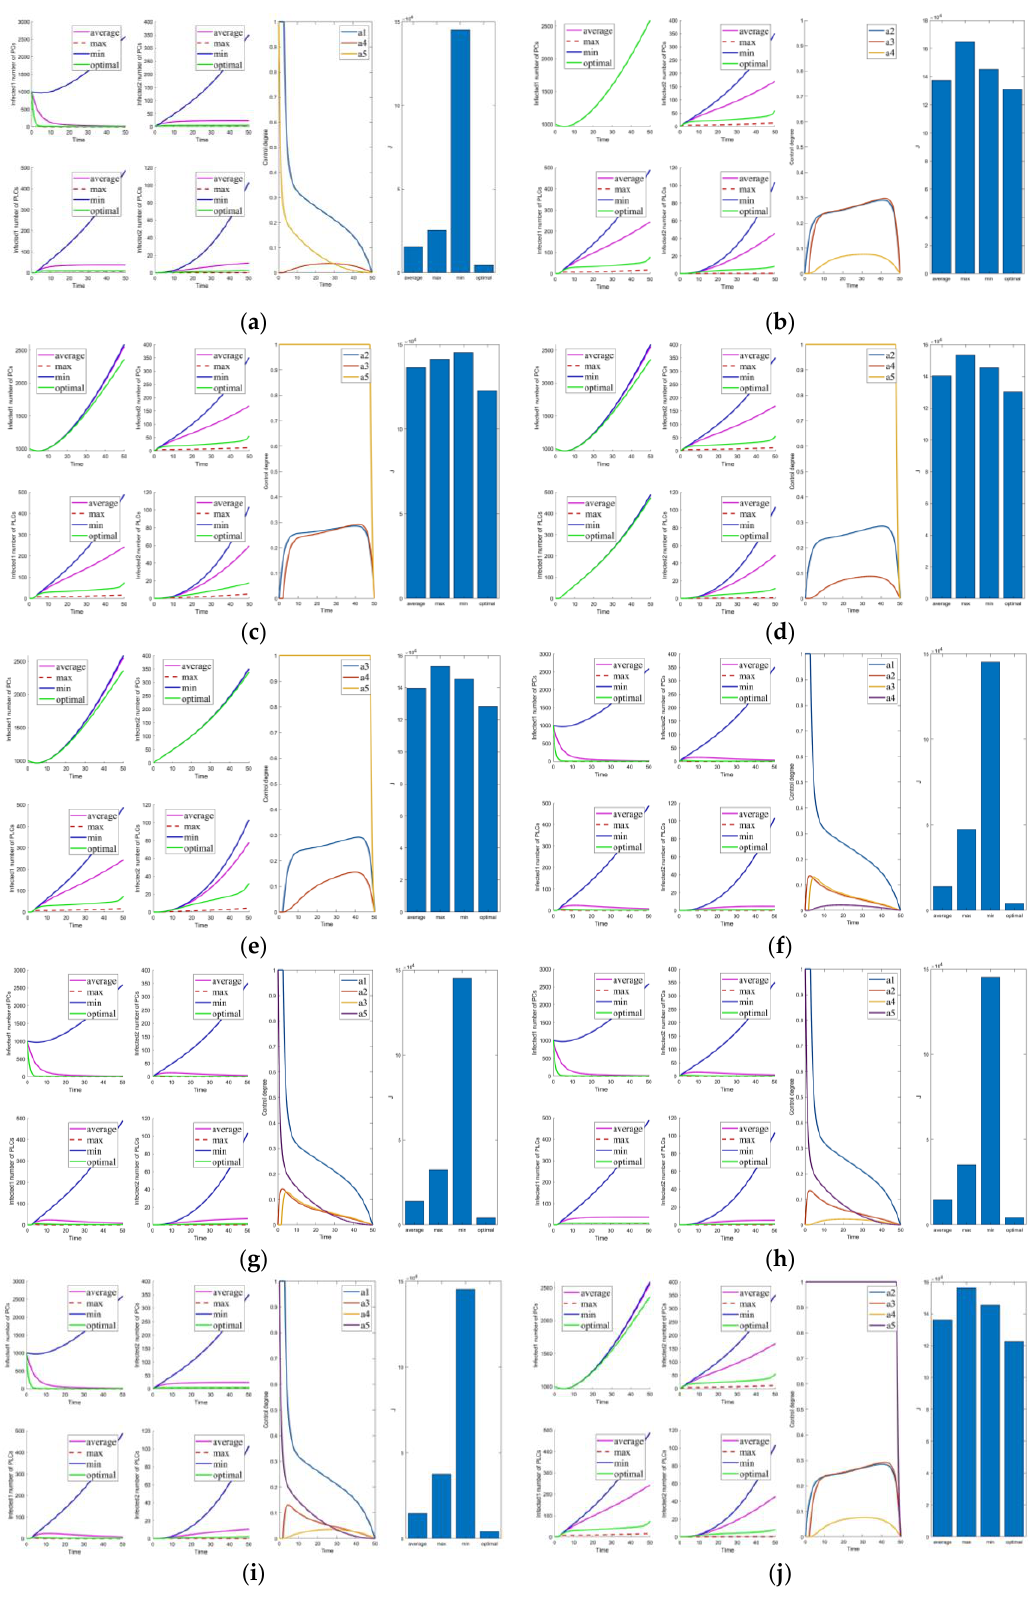
Figure 10. Solutions of the optimal control strategies for Cases 21–30 (removing average